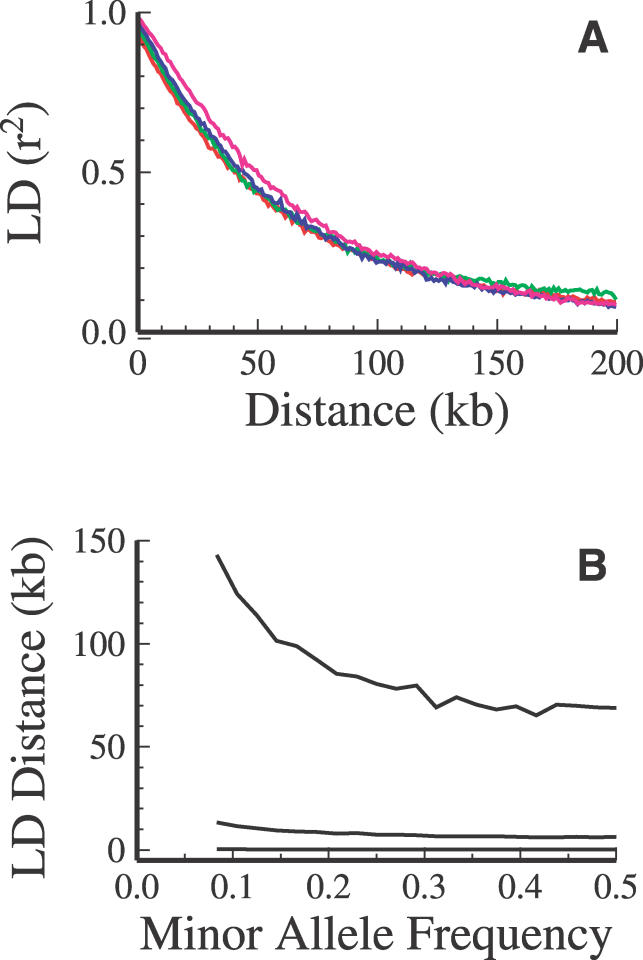
Extent of LD as a Function of Minor Allele Frequency(A) Decay of LD in the European populations for frequency bins 0.1 to 0.2 (red), 0.2 to 0.3 (green), 0.3 to 0.4 (blue), and 0.4 to 0.5 (violet). LD decay curves were calculated using only frequency-matched SNPs (Δf = 0).(B) Distance covered by perfectly correlated SNPs as a function of minor allele frequency in the Europeans. Curves represent the 0.05 (bottom), 0.50 (middle), and 0.95 (top) quantiles of the distributions.